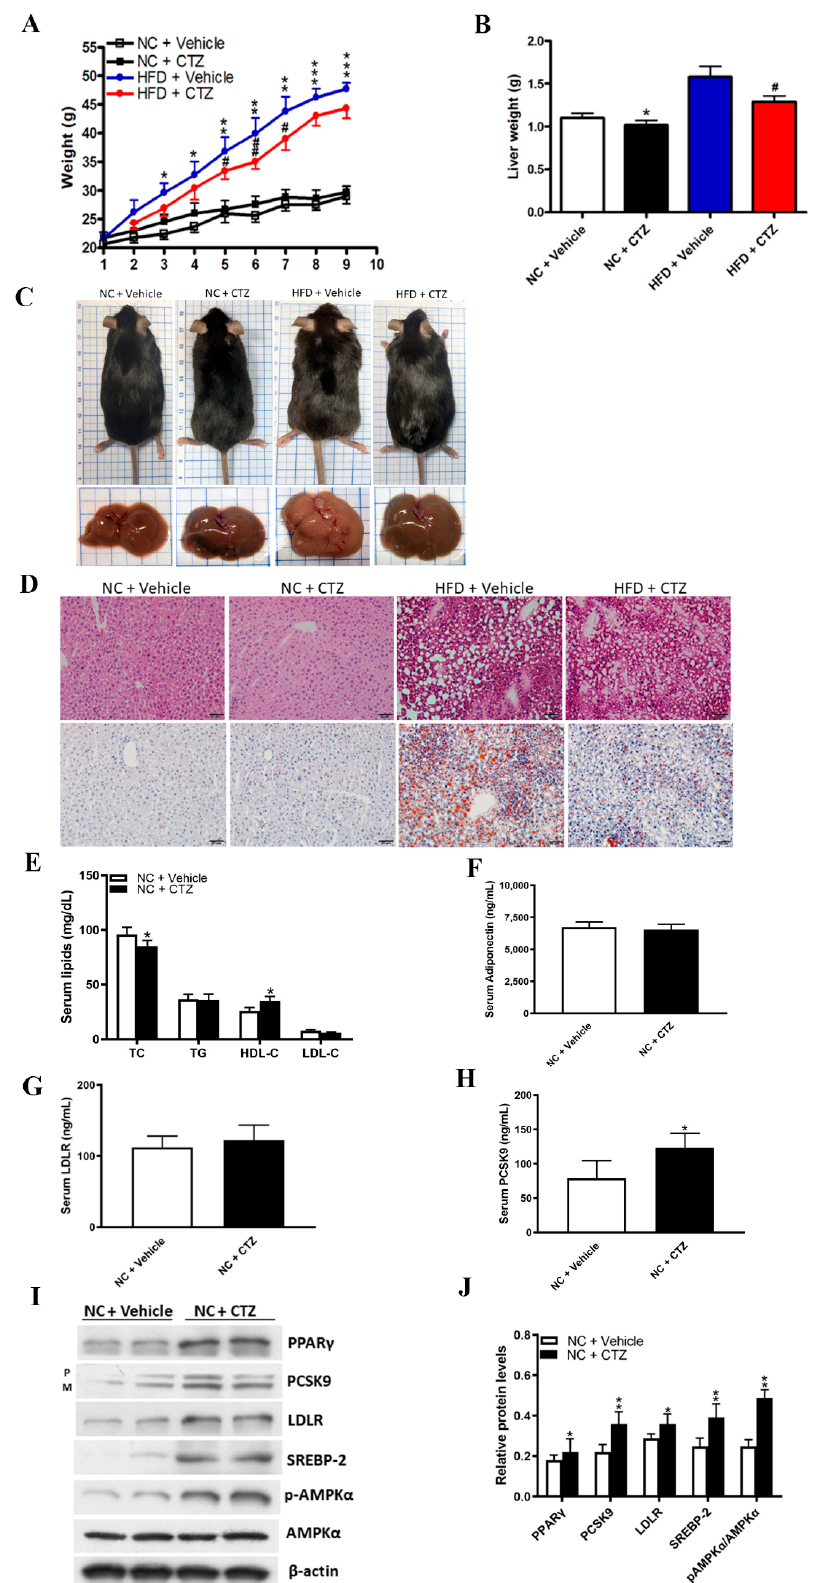
Figure 5. Effects of cilostazol on lipid homeostasis in the liver of mice fed with normal chow (NC) or high-fat diet (HFD) and lipid homeostasis-relevant profile in the serum or liver of the mice fed with NC. The mice were intraperitoneally injected with cilostazol (10 mg/kg of body weight) or